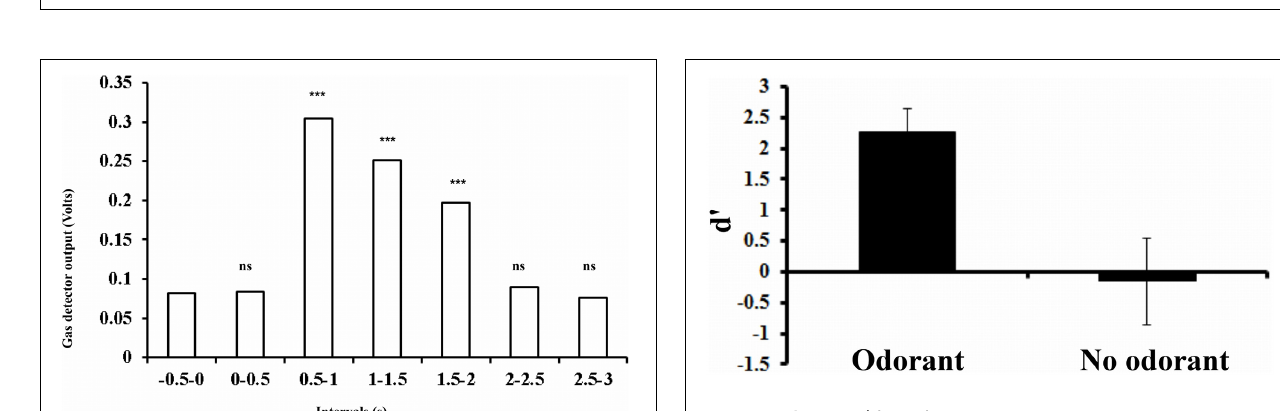
FIGURE 10 | Gas sensor output values obtained for one sequence of 15 different odorants delivery.